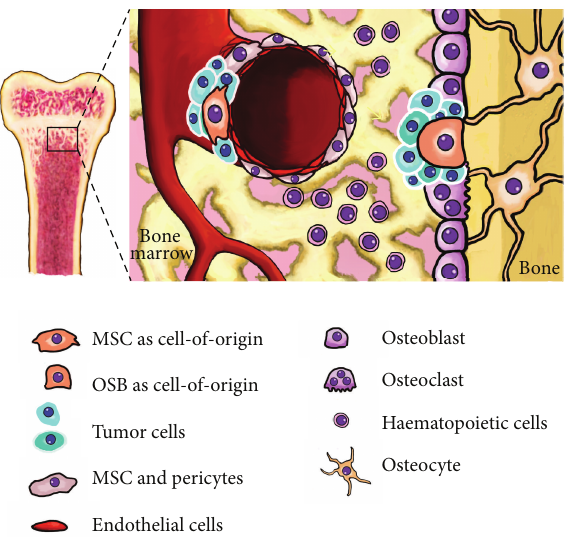
Figure 1: Cell-of-origin for OS. The figure shows the most relevant cell types present in the bone microenvironment. MSCs, repre- sented in a perivascular niche, and their derived cell types along the osteogenic lineage, such as the osteoblasts (OSB), are strong candidates to acquire the first cancer-promoting mutations and initiate OS